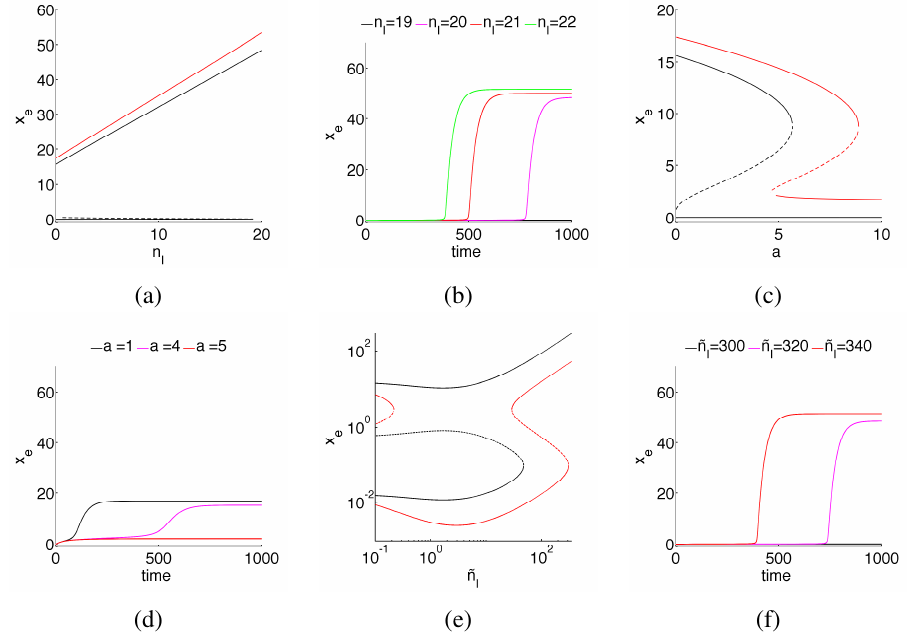
Fig. 3: Influences on LuxI. (a) Bifurcation diagram for the extracellular AHL-concentration, where only the increase in the LuxI-production by regulator n l was considered. The basal LuxI-production rate α l is 0 . 001 (black line) or 0 . 1 (red line), respectively. (b) Time courses for the extracellular AHL-concentration, which were generated by cells with different concentrations of regulator n l . Those time courses correspond to the bifurcation diagram shown in (a), with α l = 0 . 001 . (c) Bifurcation diagram for the extracellular AHL-concentration, where the influence of LexA on the system is examined. LexA destabilises LuxI and hence leads to a faster degradation of LuxI. Basal LuxI-production rate is assumed to be α l = 0 . 001 (black line) or α l = 0 . 1 (red line), respectively. (d) Time courses for the extracellular AHL-concentration, which were generated by cells with different concentrations of regulator n l . Those time courses correspond to the bifurcation diagram shown in (c), with α l = 0 . 1 . (e) Bifurcation diagram, where in addition to the increased LuxI-production by regulator ˜ n l , a destabilising effect of regulator ˜ n l on LuxI is assumed. Basal LuxI-production rate is 0 . 1 . The destabilising effect is p n = 10 (red line). (f) Time courses for the extracellular AHL-concentration, which were generated by cells with different concentrations of regulator ˜ n l . Those time courses correspond to the bifurcation diagram shown in (e), with p n l